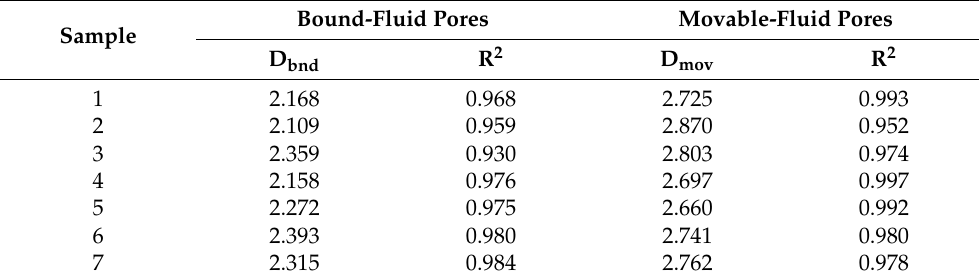
Figure 14. The plot of lg(f r ) versus Lg( T 2 ) using NMR from Sample 2. ( A ) the saturated water distribution; ( B ) the fractal curve of saturated water. Table 7. Fractal Dimensions of the samples from NMR with water